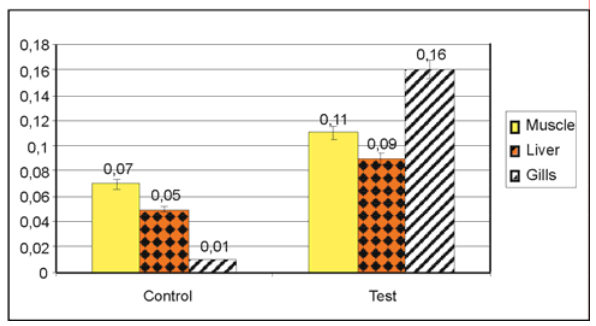
Fig. 4. Copper concentration (mg/kg) in tissues of stone loach